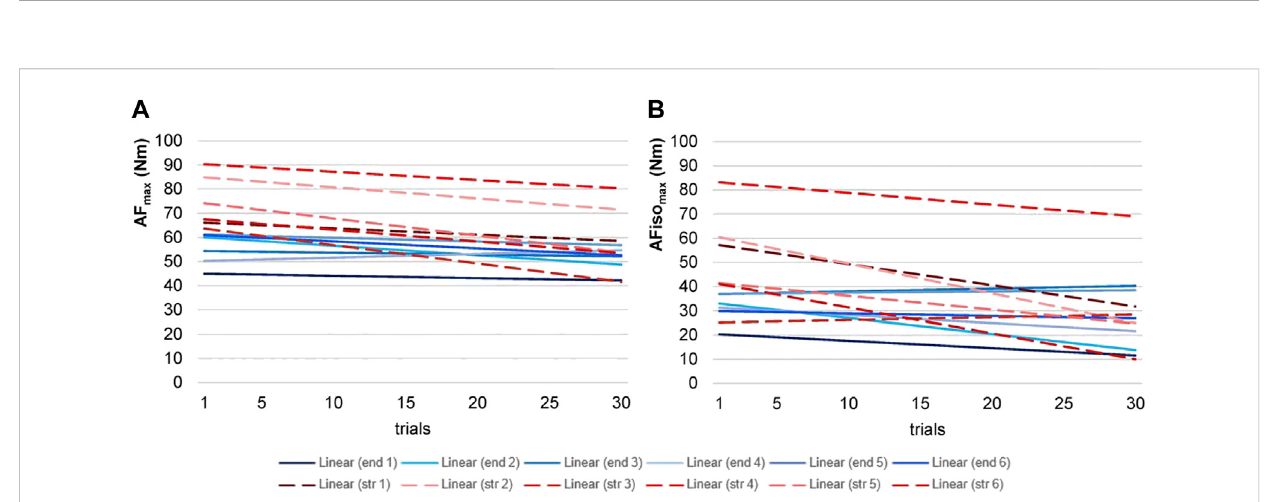
FIGURE 4 Regression lines of AdaptiveForce parameters. Displayed are theregression lines ofthe torques of maximal Adaptive Force (AF max , (A) ) and maximal isometric AF (AFiso max , (B) ) of the 30 trials of each participant (endurance = end (blue), n = 6; strength = str (red, dashed), n =